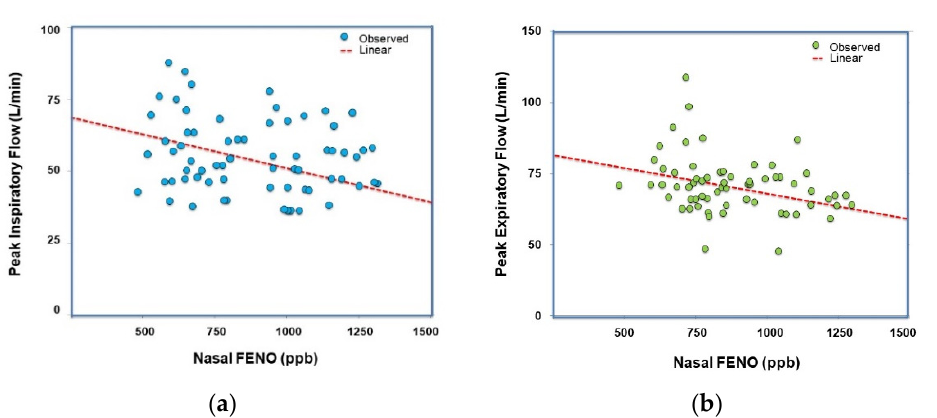
Figure 1. ( a ) Correlation between nasal FENO and peak inspiratory flow in patients with AR. ( b ) Correlation between nasal FENO and peak expiratory flow in patients with AR. AR: allergic rhinitis; FENO: fractional exhaled nitric oxide. Table 3. Correlation between nasal FENO and nasal peak flow of study subjects.